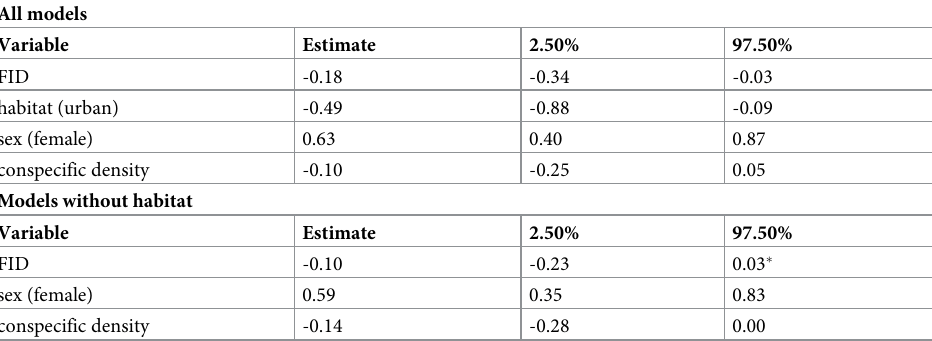
Table 2. Relative importance of individual’s traits (sex and personality, measured as FID), and social variables (conspecific density and productivity in the natal area) on the natal dispersal distances of rural and urban (habi- tat) burrowing owls Athene cunicularia . Estimates and 95% confidence intervals (2.5% and 97.5%) obtained after averaging models in Table 1 (all models) and using the subset of models that did not include habitat (models without habitat). We considered that a given variable has no, weak or strong support when the 95% confidence interval strongly overlapped with zero, barely overlapped with zero (asterisk), or did not overlap with zero (in bold), respectively.